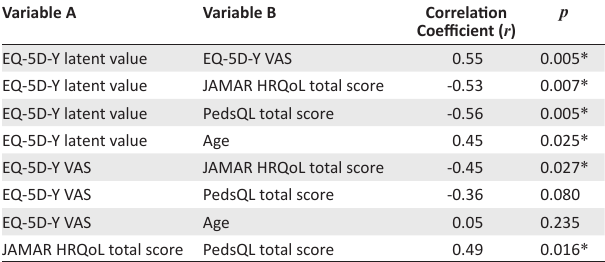
TABLE 2b: Correlations between outcome measures for males. n = 24.